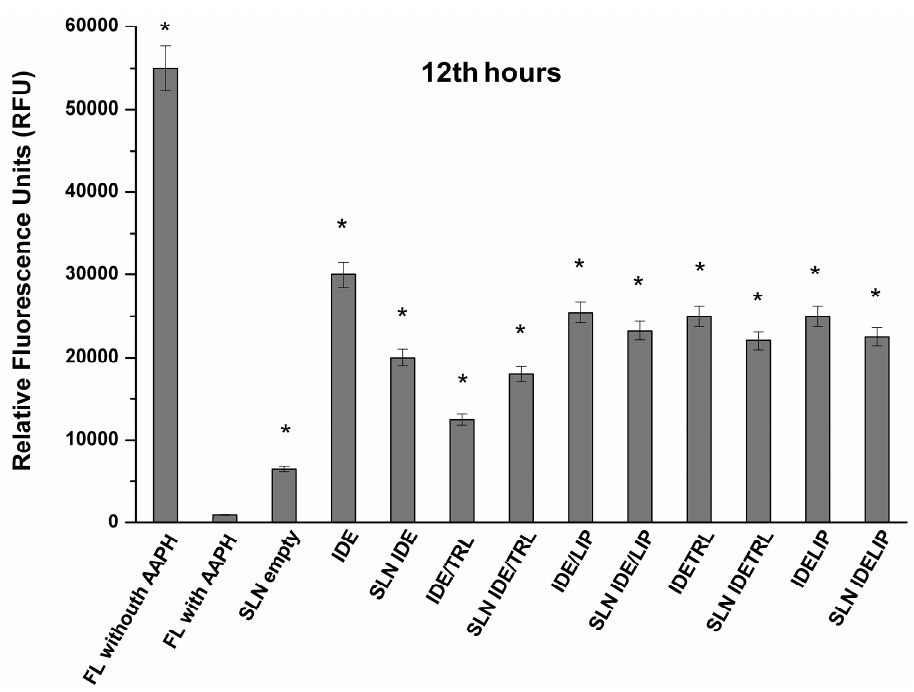
Figure 5. Antioxidant efficiency of IDE, IDETRL, IDELIP, and of the physical mixtures IDE/TRL and IDE/LIP, free or loaded into SLN, at the 12th hour. Data represent the mean of three independent experiments ± SD. * p < 0.05 with respect to the positive control.